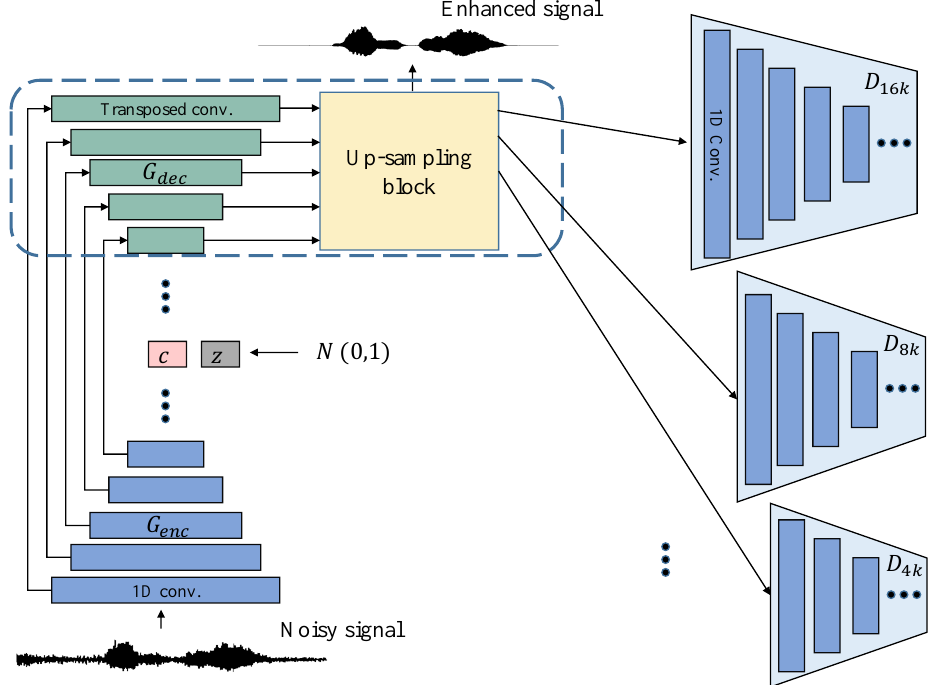
Figure 2. Overall architecture of the proposed GAN-based speech enhancement. The up-sampling block and the multiple discriminators D n are newly added, and the rest of the architecture is the same as that of [26]. The components within the dashed line will be addressed in Figure